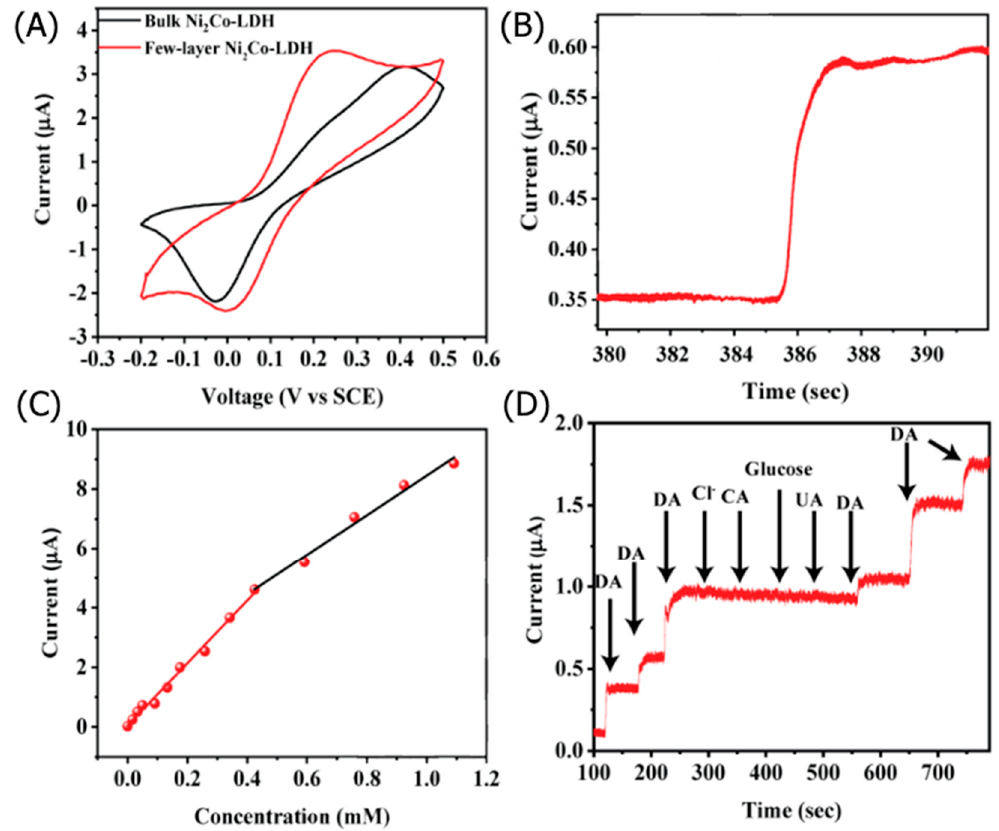
Figure 2. ( A ) CV curves for bulk and exfoliated CoNi 2 -LDH with 0.17 mM of DA at a scan rate of 50 mV s − 1 ; ( B ) chronoamperometric response of exfoliated CoNi 2 -LDH; ( C ) calibration curve for the linear response of current vs. DA concentration; and ( D ) selectivity for DA sensing, reproduced from reference [41], with permission from Elsevier, 2021.